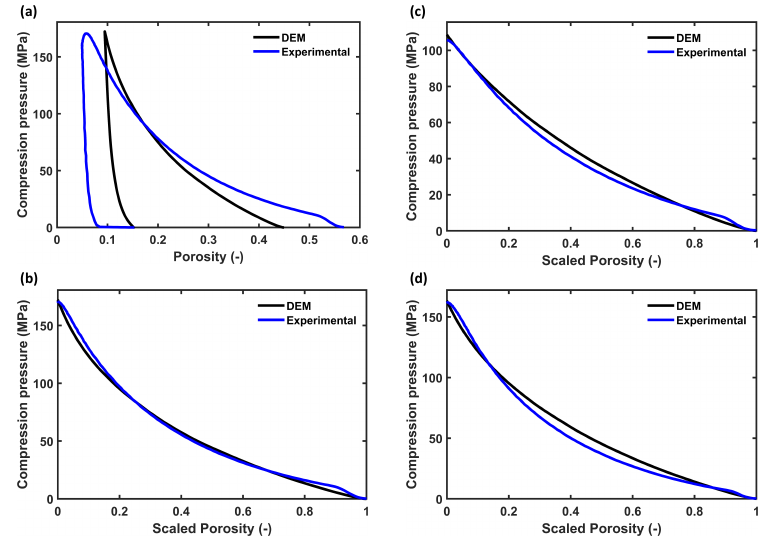
Figure 5. Comparison of experimental and DEM compression profiles. ( a ) Full compression profile of MCC PH101 tablet with a porosity of 15%. ( b ) Loading profile of MCC PH101 tablet with a porosity of 15% with scaled (to correct for the initial difference in porosity between experiment and DEM) porosity used for DEM parameter estimation. The validation data are shown in ( c ) for MCC PH101 (cid:101) 0 = 22% and ( d ) for PH101/CCS with c CCS = 2%.